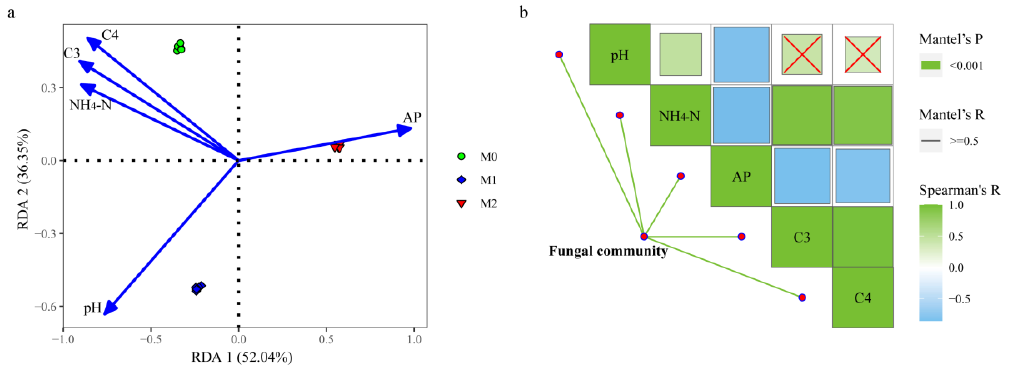
Figure 3. Redundancy analysis of fungal community structure and soil properties ( a ). AP—available P; C3—less labile fraction of oxidizable carbon; C4—nonlabile fraction of oxidizable carbon. Spear- man’s correlation analysis and Mantel tests for fungal communities ( b ). Red crosses indicate p > 0.05. Edge width corresponds to the Mantel’s R value and the edge color denotes the statistical